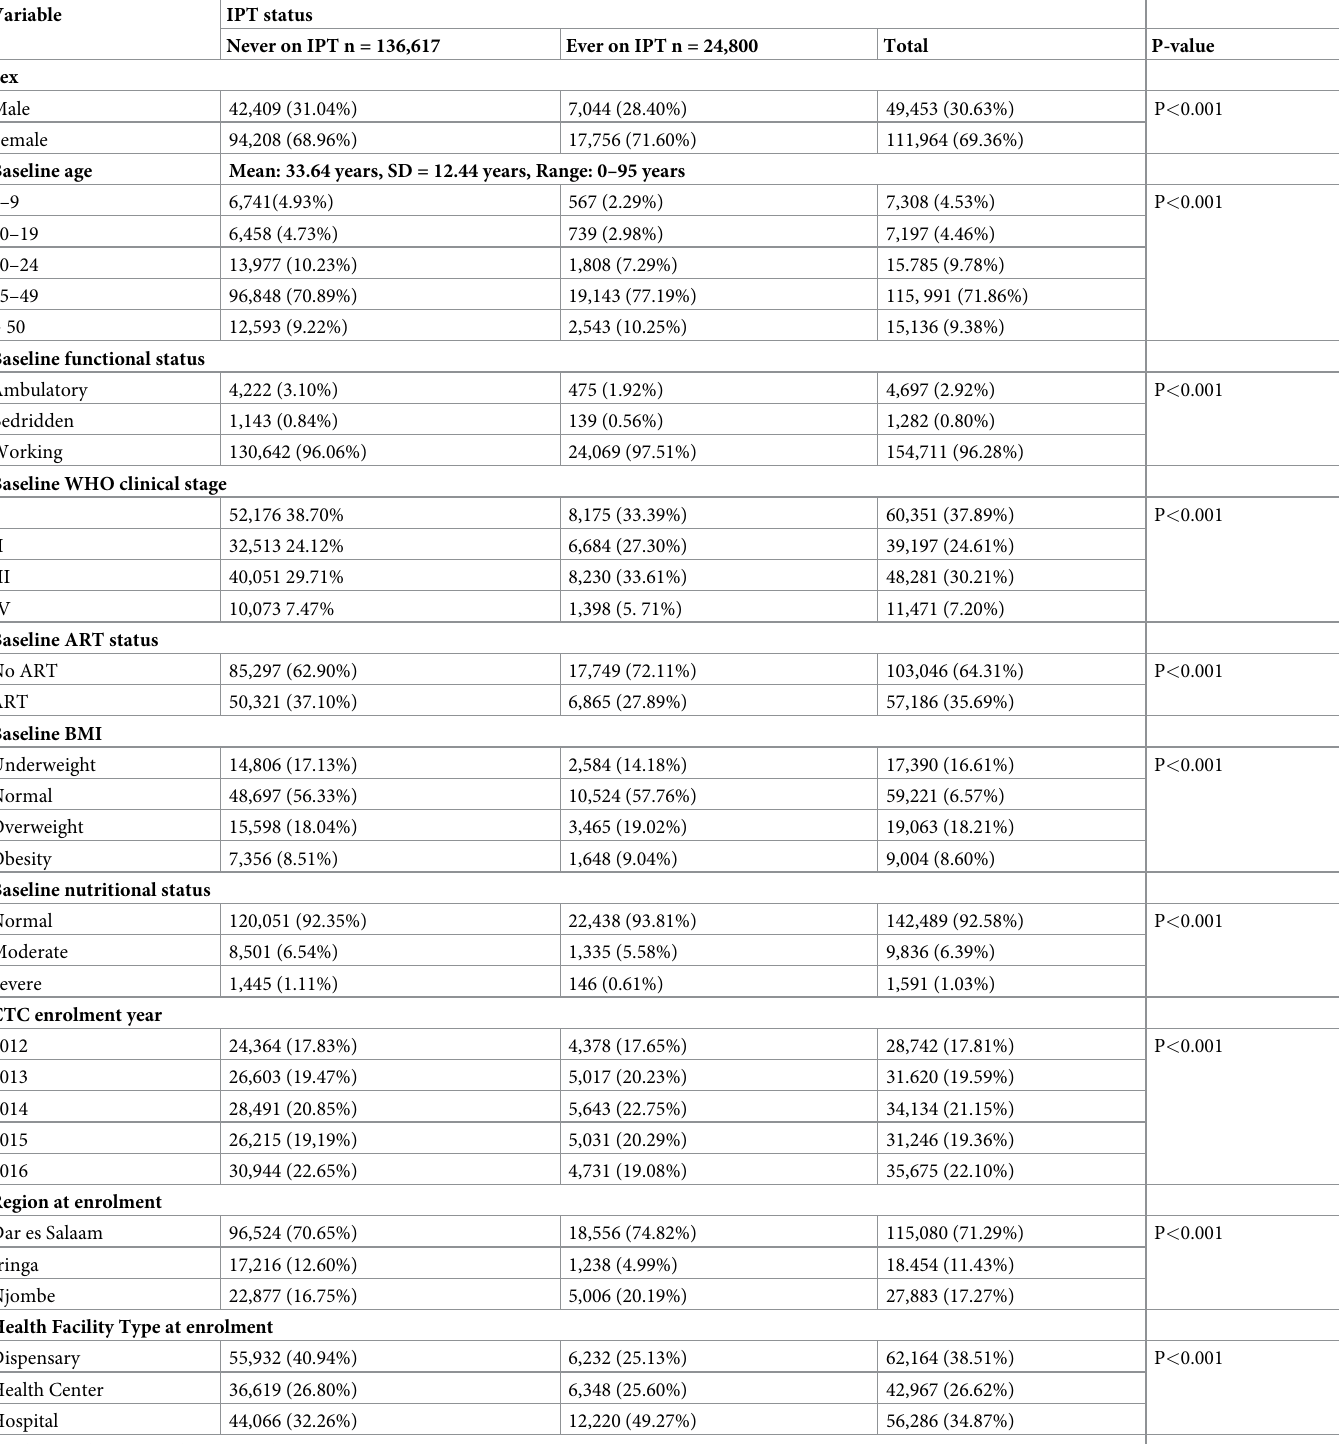
Table 1. Baseline characteristics of study participants, N =